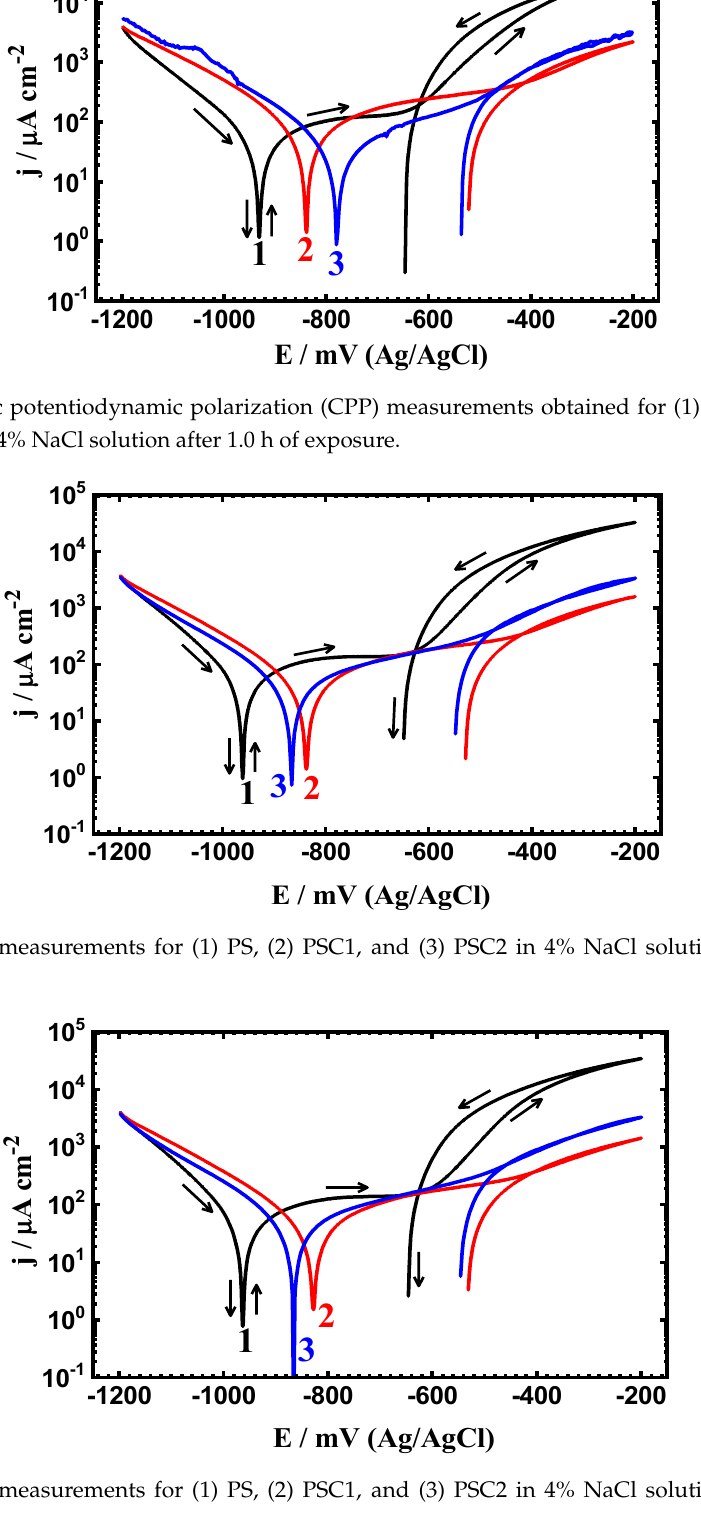
Figure 7. CPP measurements for (1) PS, (2) PSC1, and (3) PSC2 in 4% NaCl solution after 48 h of exposure.